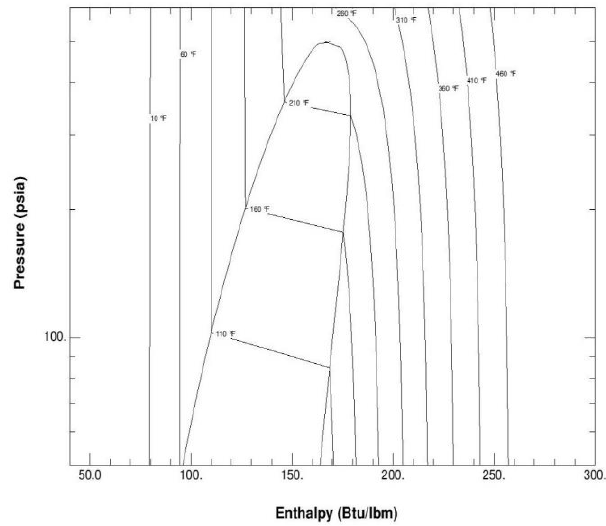
Figure 2. P-H diagram for the mixture R134a, R245fa, R125, R236fa.